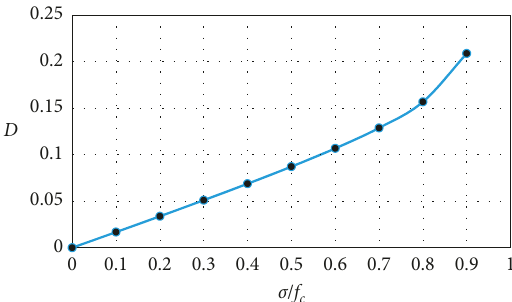
70% of the beam strength, L (cid:29)